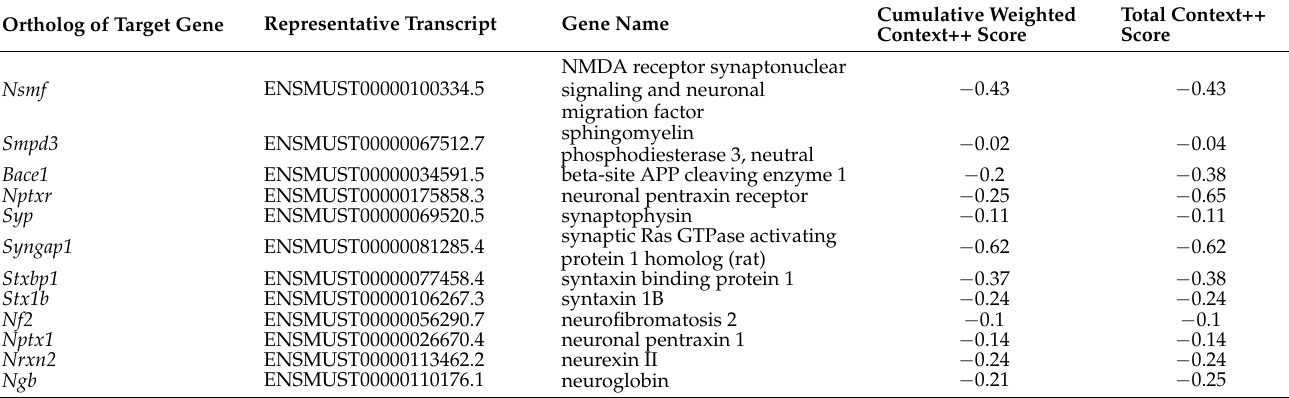
Table 3. Predicted target genes of miR-342-5p concerning neural